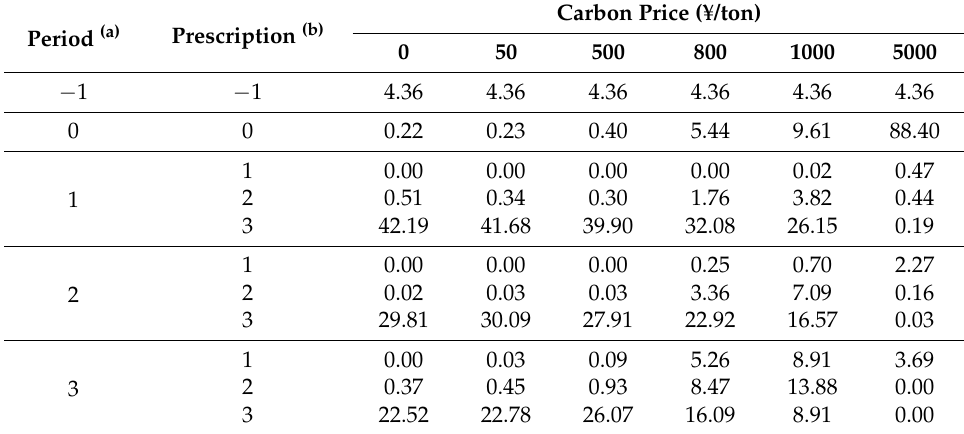
Table 1. Percentage of harvested units with alternative management prescriptions when a carbon price of 0, 50, 500, 800, 1000, and 5000 ¥/ton was